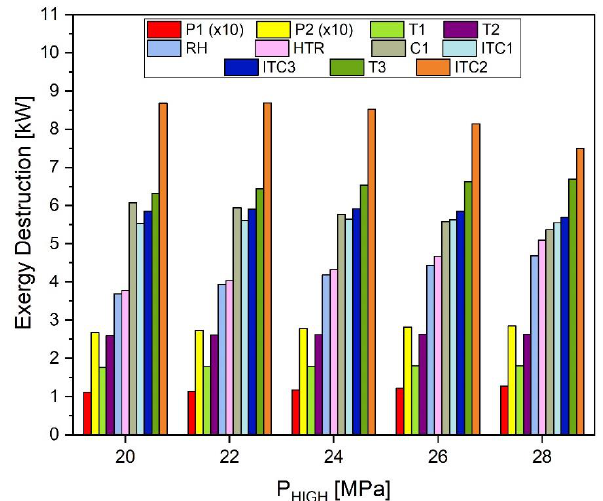
Figure 9. Components destroyed exergy with respect to P HIGH .